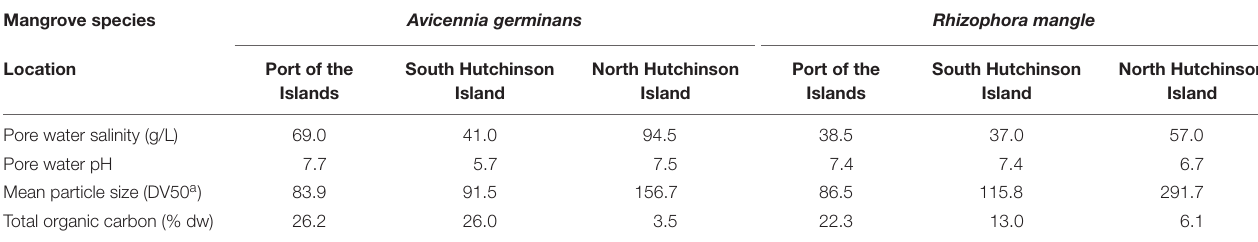
TABLE 1 | Characteristics of mangrove forest soil samples collected from Florida,